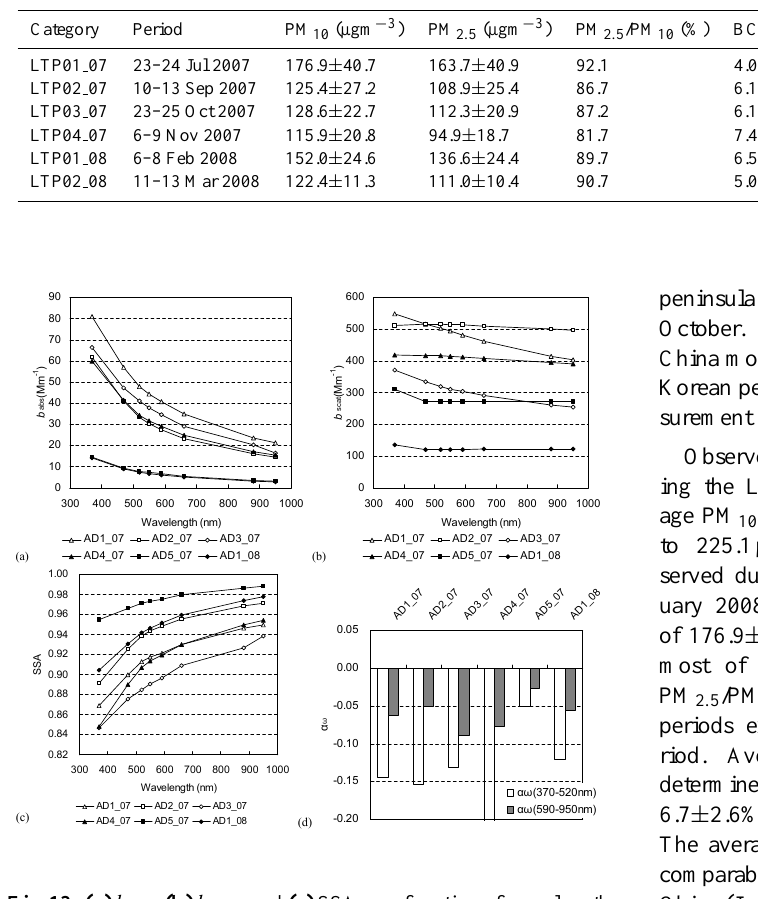
Fig. 13. (a) b abs , (b) b scat , and (c) SSA as a function of wavelength as well as (d) ˚Angstr¨om exponent ( α ω ) of SSA during the Asian dust